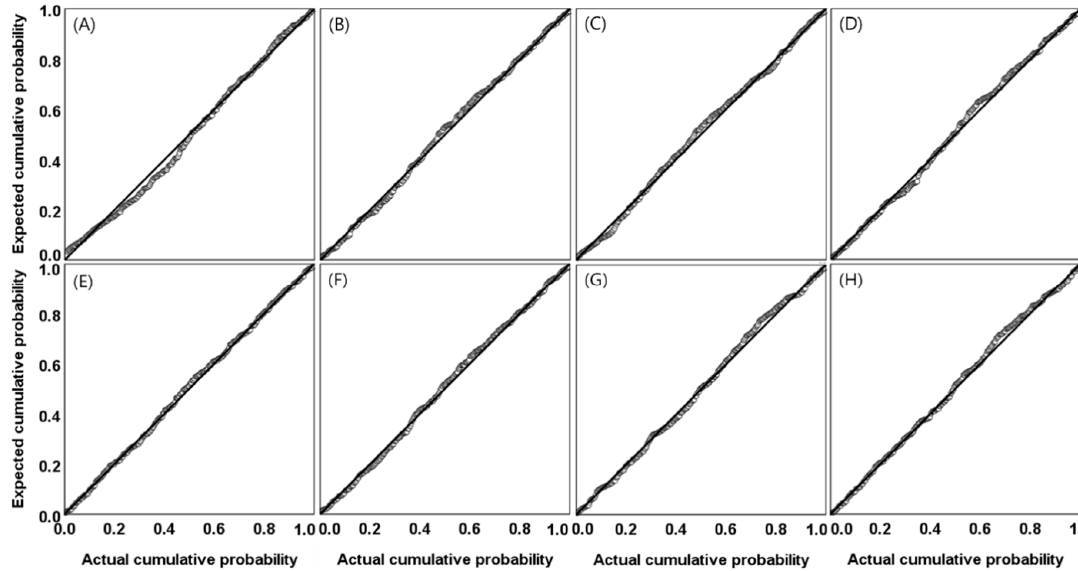
Figure 6. P–P plots of the regression-normalized residuals of the expected cumulative probability versus actual cumulative probability for each regression Model ( A – H ): Model A = axle torque as a linear function of engine torque and engine speed; Model B = axle torque as a linear function of tillage depth; Model C = axle torque as a linear function of slip ratio and travel speed; Model D = axle torque as a linear function of engine torque, engine speed and tillage depth; Model E = axle torque as a linear function of engine torque, engine speed and travel speed; Model F = axle torque as a linear function of tillage depth and travel speed; Model G = axle torque as a linear function of engine speed, tillage depth and travel speed; and Model H = axle torque as a linear function of engine torque, tillage depth and travel speed.